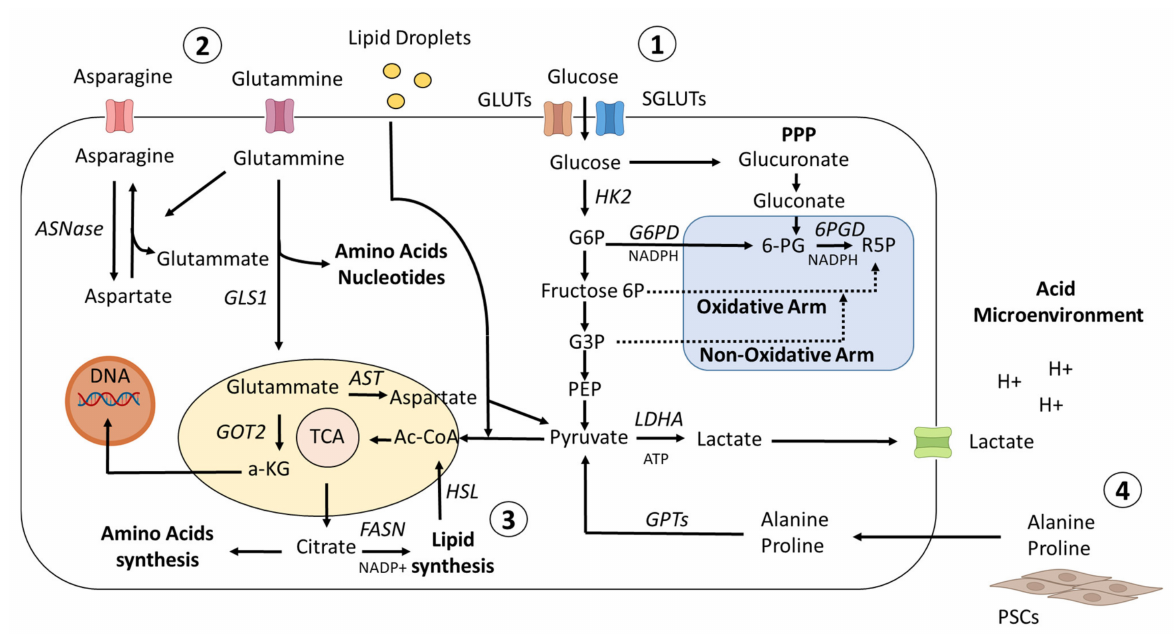
Figure 1. Metabolic landscape in PDAC. ( 1 ) To promote glucose uptake in PDAC cells, KRAS and HIF1 upregulate the GLUT family of genes and other genes associated with glycolysis. While a portion of the glycolytic cascade is used to fuel oxidative phosphorylation and the production of ATP, or alternatively to promote lactate, which helps to create an acidic microenvironment, another branch of the process is directed toward the PPP pathway to provide precursors for nucleotide and